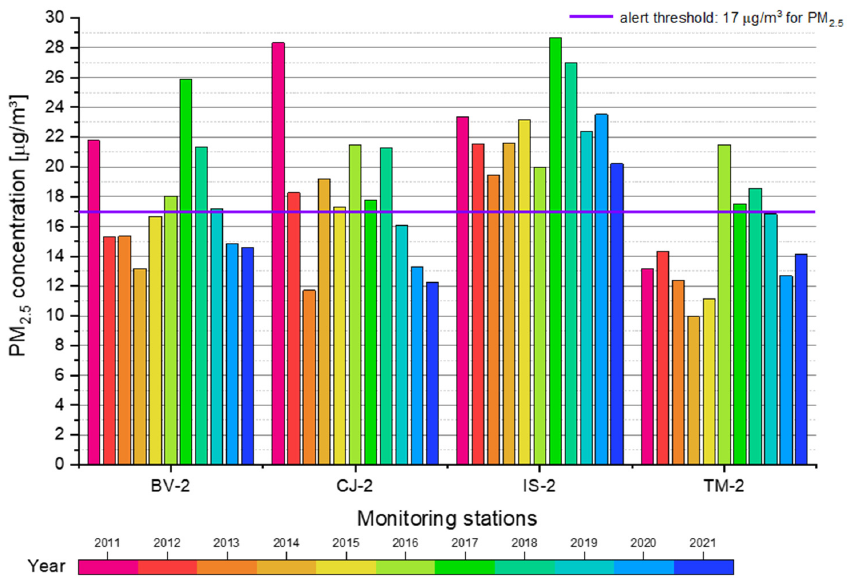
Figure 2. Average annual concentration of PM 2.5 in the four cities (Brasov, Cluj-Napoca, Iasi, and Timisoara).